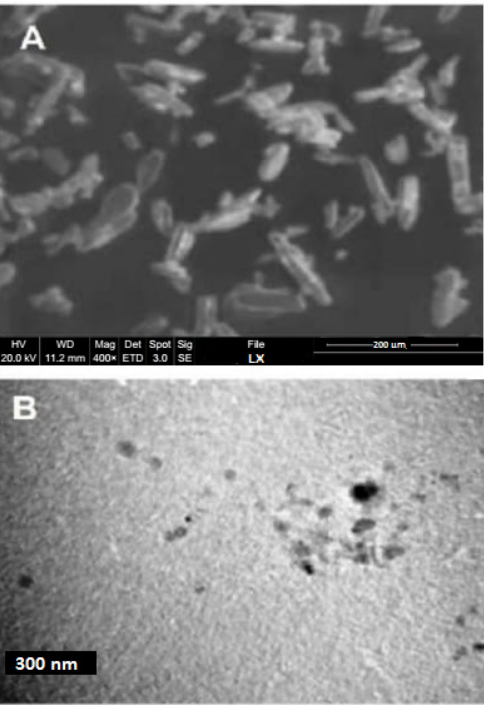
Figure 1. ( A ) Morphology of pure powder LX by SEM. ( B ) Morphology of LX NCS by TEM.